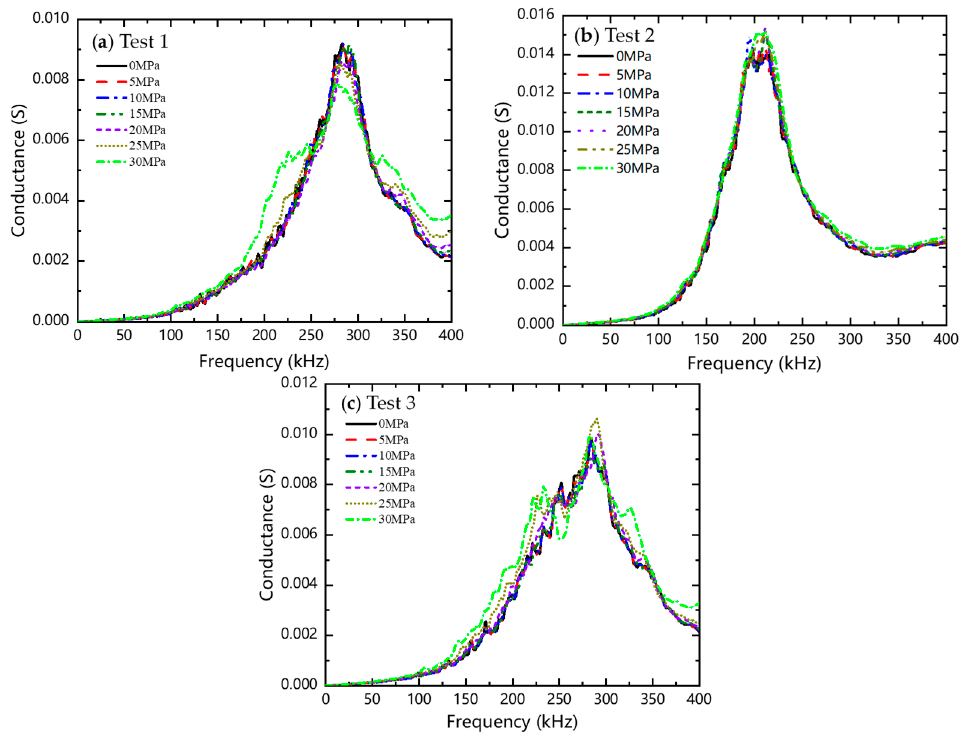
Figure 12. Conductance signatures obtained from the experimental tests in concrete cubes with the 90° flat PZT sensors. 90 ◦ flat PZT